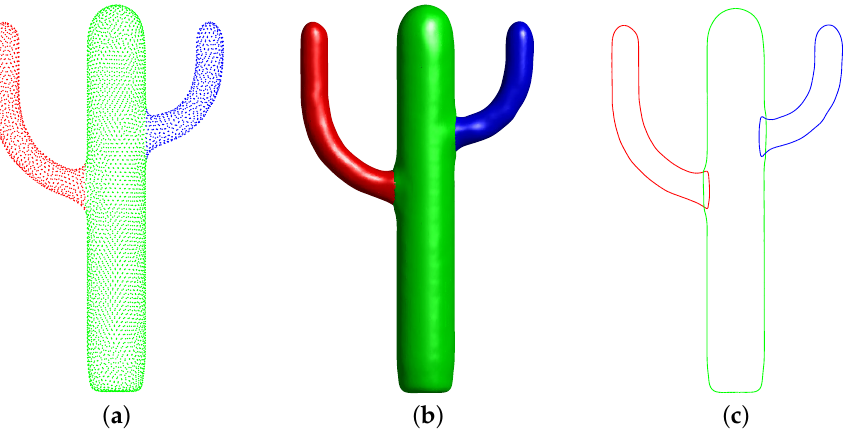
Figure 1. ( a ) The point cloud. ( b ) The surfaces that are obtained by signal Poisson surface reconstruc- tion [6]. ( c ) The result in the cross-view of ( b